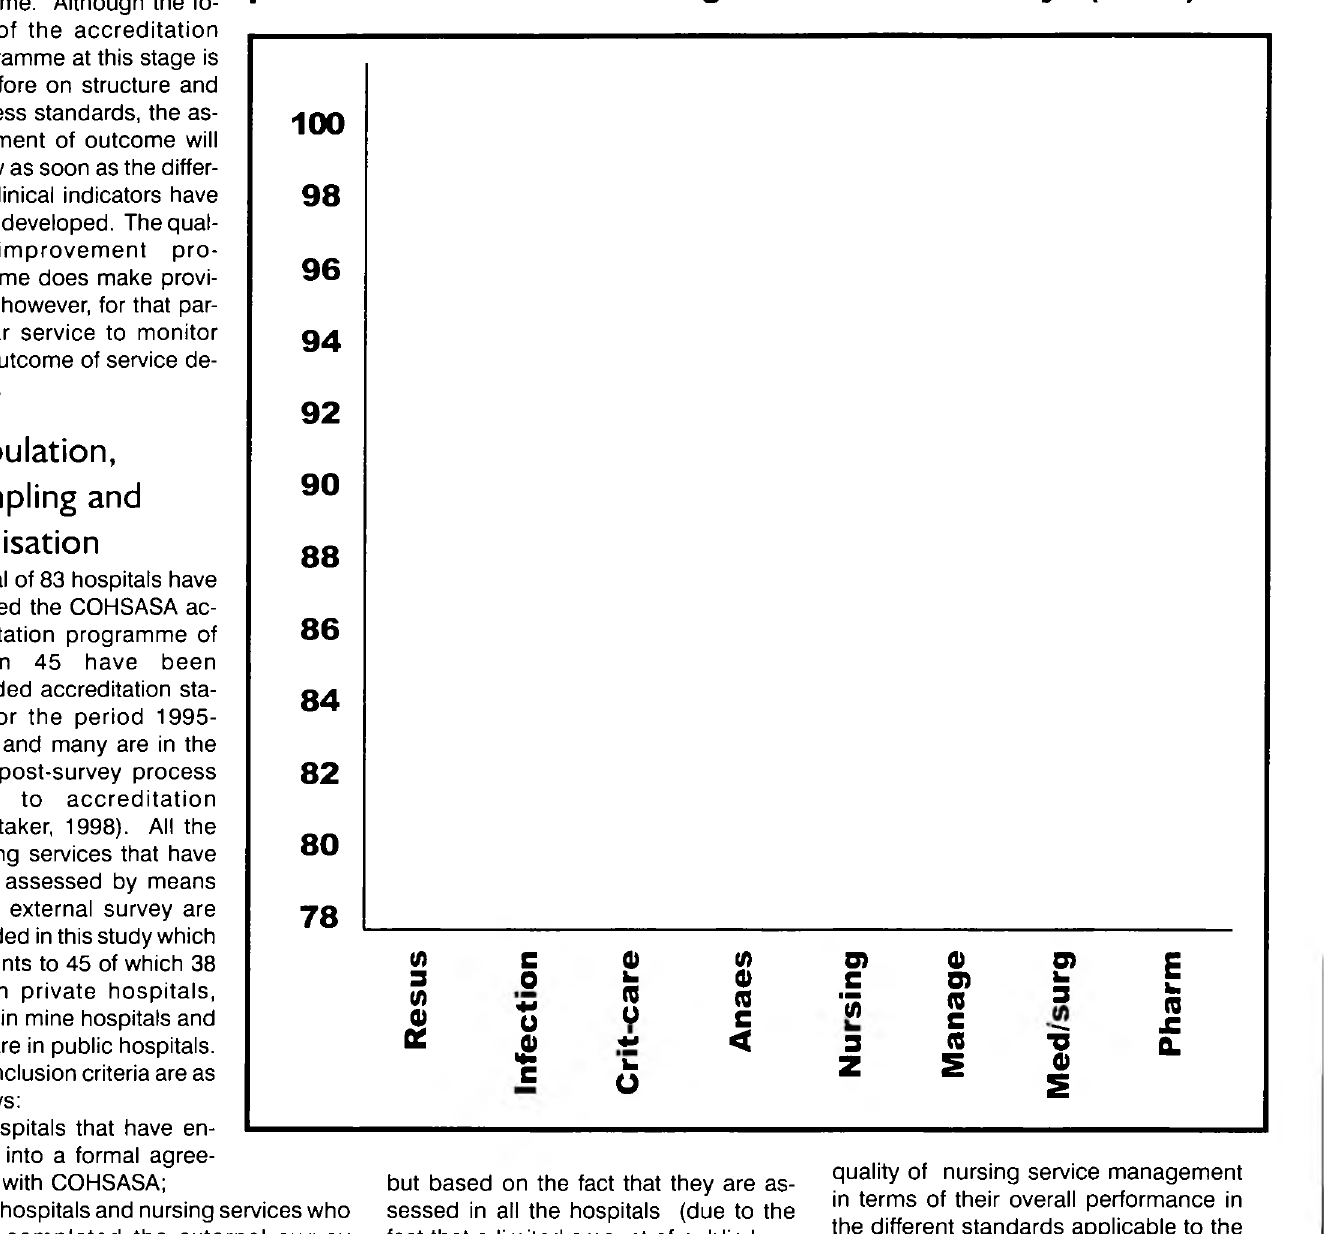
Figure 1 : O verall com p arative perfo rm an ce of selected professional services during th e e x te rn a l surveys (N =45)